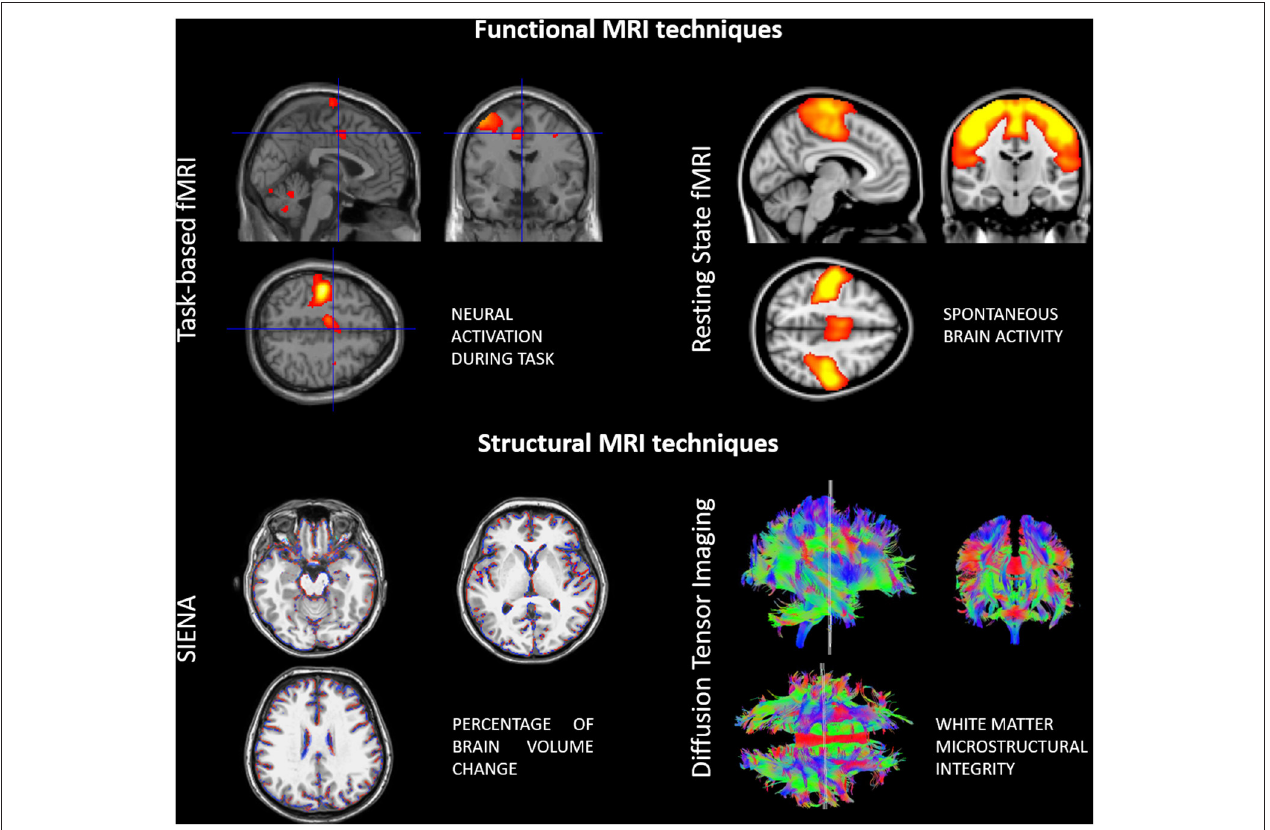
FIGURE 1 | Examples of advanced functional and structural MRI techniques used for assessing neuroplasticity in multiple sclerosis